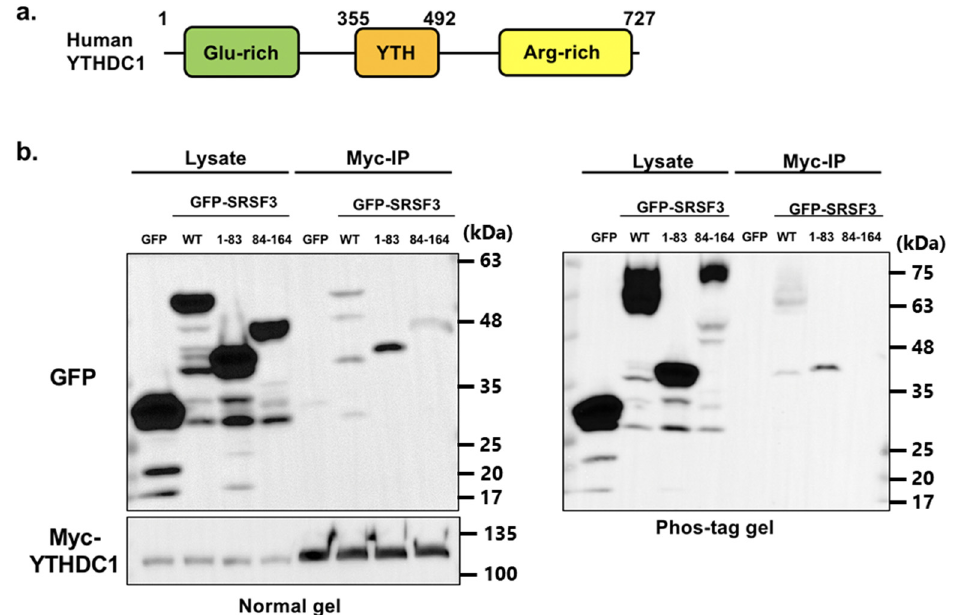
Figure 4. Interaction validation of YTHDC1 with SRSF3. ( a ) YTHDC1 and its fragment structure indicating the position of glutamic acid-rich region (Glu-rich), YT521-B homology (YTH) domain and arginine-rich region (Arg-rich). ( b ) HeLa cells were co-transfected with GFP-SRSF3, Myc-YTHDC1, or their mutants. The lysates of co-transfected cells were immunoprecipitated using anti-Myc antibody. Myc-YTHDC1 interaction with GFP-SRSF3 and its fragments was detected by western blotting using anti-GFP or anti-Myc antibodies ( b , left); the result of phos-tag gel is also shown in ( b , right). Some nonspecific bands are observed.